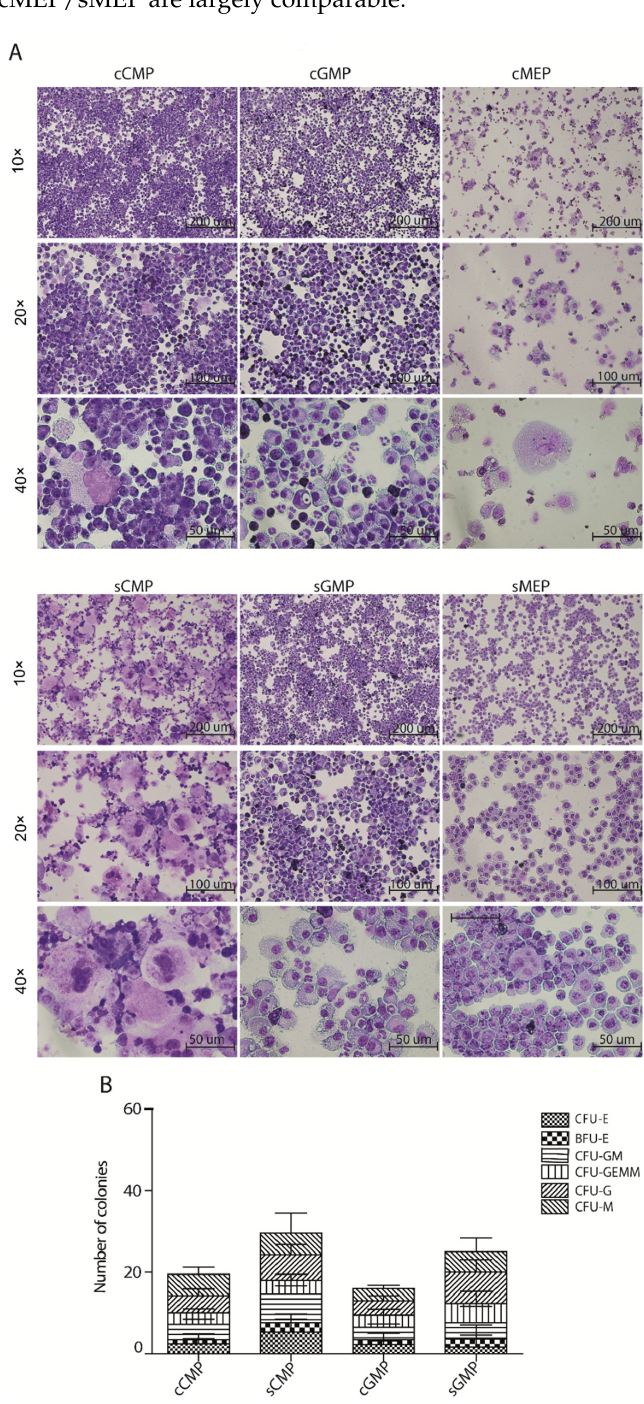
Figure 3. Morphological assessment of CD34/Fc γ R like CD34/CD150 sub-populations finds compa- rable phenotype ex vivo . ( A ) LK cells sorted by CD34/Fc γ R or by CD34/CD150. Giemsa staining of cells derived from defined sub-populations after eight days in culture. Scale bar = 200, 100, and 50